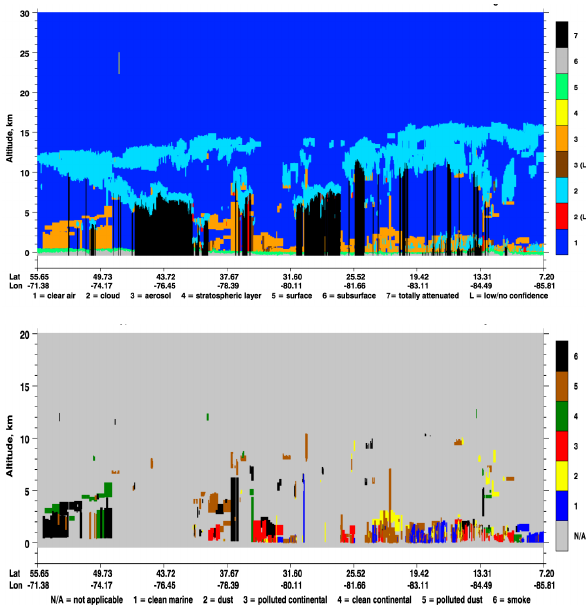
Fig. 16. CALIPSO vertical feature mask (top) and aerosol subtype (bottom) plots near CORALNet Sherbrooke on 28 June at approx- imately 07:18UTC ( http://www-calipso.larc.nasa.gov/products/ lidar/browse images/show date.php?s=production \ &v=V3-01 \ &browse